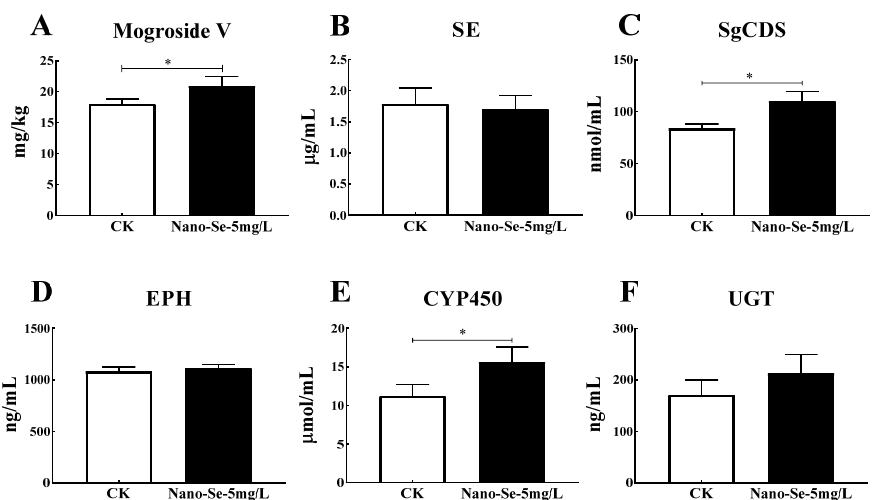
Figure 1. Effects of nano-Se on mogroside V ( A ), SE ( B ), SgCDS ( C ), EPH ( D ), CYP450 ( E ), and UGT ( F ) contents in S. grosvenorii . Data are presented as mean ± SEM (* p < 0.05. n = 3). Squalene epoxidase (SE), cucurbitadienol synthase (SgCDS), epoxide hydrolase (EPH), cytochrome P450 (CYP450), and UDP-glucosyltransferase (UGT).